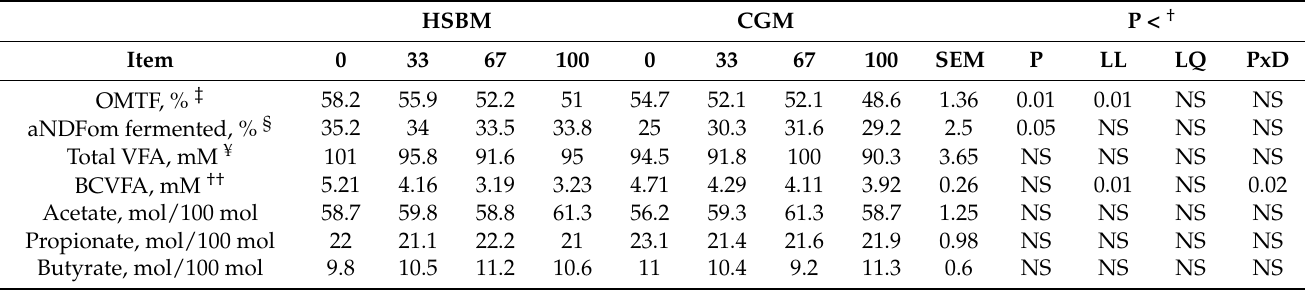
Table 3. Organic matter digestion and volatile fatty acid concentrations in continuous